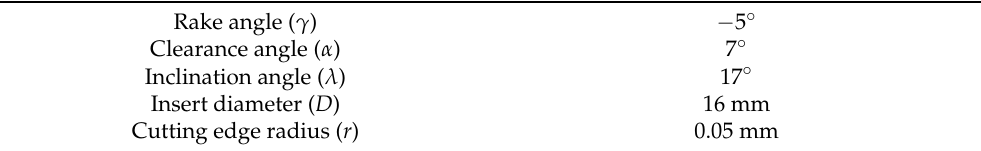
Table 2. Cutting tool geometry parameters.